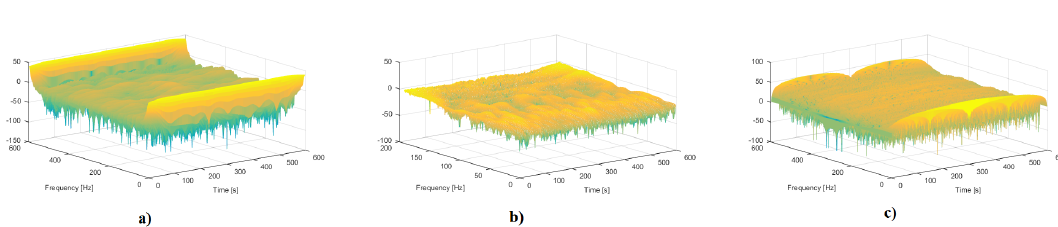
Figure 9. Representation of measured responses in the time domain for ( a ) pitch and ( b ) roll motions.